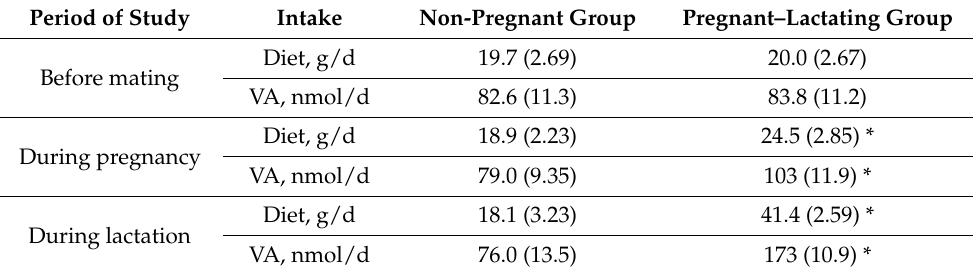
Table 1. Average intakes of diet and VA at different stages for non-pregnant and pregnant–lactating rats 1 . Period of Study